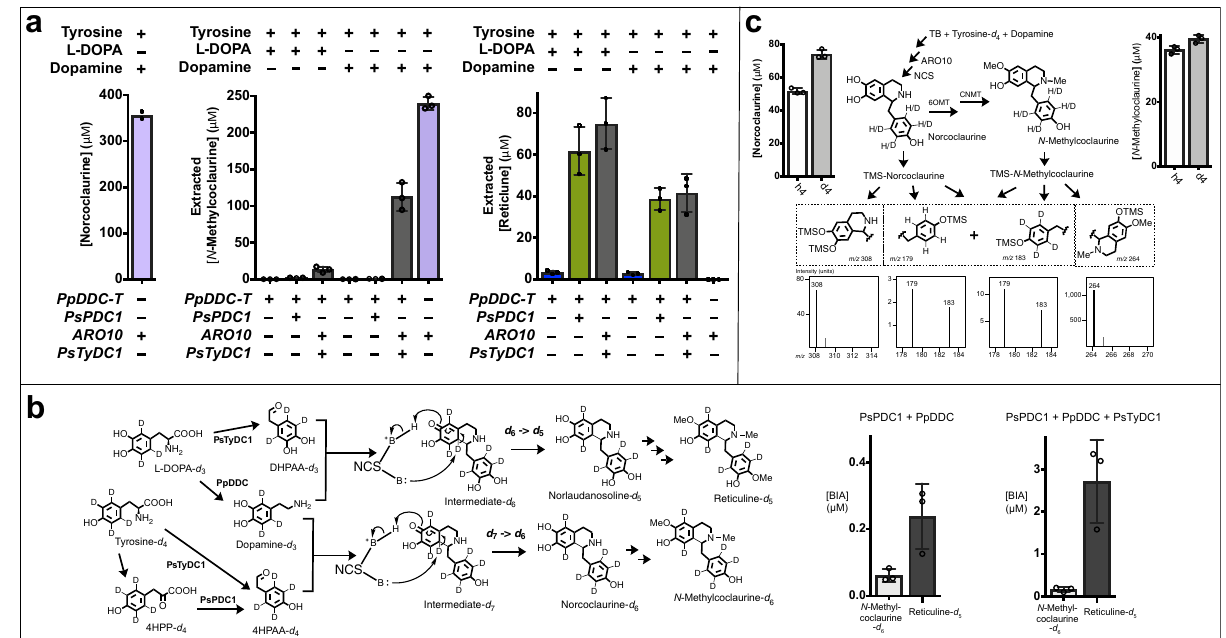
Fig. 8 Optimization of norcocluarine, reticuline, and N -methylcoclaurine production for analysis of fl ux through hybrid pathways. a PpDDC-Y79F- F80Y-H181N (PpDDC-T) and PsPDC1 containing strain P1-07-AI (olive green) prefers the norlaudanosoline containing pathway. Combination of PpDDC-T, ARO10 and PsTyDC1 in strain A1-06-AI (dark grey) promotes both norcoclaurine and norlaudanosoline containing pathways. ARO10 expressing strain A1- 01-DE3 (light purple) converts tyrosine and dopamine to norcoclaurine and N -methylcoclaurine. N -Methylcoclaurine and reticuline were extracted with ethyl acetate from cultures 40 h after addition of tyrosine together with L-DOPA or dopamine. Tested strains P1-06-DE3 (blue), P1-07-AI (olive green), A1- 06-AI (dark grey) and A1-01-DE3 (light purple) each contain Cj6OMT, CjCNMT, Cj4OMT, NCS, plus the indicated genes of the bottom 4 rows. P1-06-DE3 and P1-07-AI contain the same genes, but P1-06-DE3 was induced with only IPTG, without including arabinose for PsPDC1 expression. Cultures containing PpDDC-T and L-DOPA were supplemented with additional sodium ascorbate. The BL21(AI) derived strain P1-07-AI was induced with IPTG and arabinose. For improved N -methylcoclaurine production, A1-01-DE3 was supplemented with the aldehyde reductase/dehydrogenase inhibitor gossypol. Additional culture conditions are described in the methods section. Extracted N -methylcoclaurine and reticuline were TMS-derivatized and analyzed with GC-MS ( t = 40 h, n = 3). After extraction, cultures were stored at 4 °C and stable norcoclaurine titers from culture medium were analyzed with LC-MS ( n = 2). b Isotope pro fi ling of strains P1-02-AI (expressing PsPDC1) and P1-04-AI (expressing PsPDC1 and PsTyDC1), which produce N -methylcoclaurine- d 6 (P1-02- AI - 62 nM, P1-04-AI 160 nM) and reticuline- d 5 from tyrosine- d 4 and L-DOPA- d 3 ( t = 61 h, n = 3). There is a synergistic improvement in BIA production when combining PsPDC1 and PsTyDC1. Here, NCS catalyzes the loss of a deuterium from in vivo generated dopamine- d 3 . c For tracing aromatic isotope fl ux from tyrosine to norcoclaurine and N -methylcoclaurine, alkaloids were extracted with ethyl acetate from the A1-01-DE3 culture 40 h after addition of tyrosine- d 3 and dopamine, according to the methods section. Extracted alkaloids were TMS-derivatized and analyzed with GC-MS ( n = 3). After extraction, cultures were stored at 4 °C and stable BIA titers from culture medium were analyzed with CE-MS ( n = 3); the fraction of labeled BIA- d 4 and unlabeled BIA from natural tyrosine in the rich TB broth can be quanti fi ed. With exception to unlabeled norcoclaurine ( n = 2), all other individual samples were analyzed 3 times ( n = 3) to generate bar graphs in Prism 7, with error bars representing mean values + / − standard deviations. Source data are provided as a Source Data fi